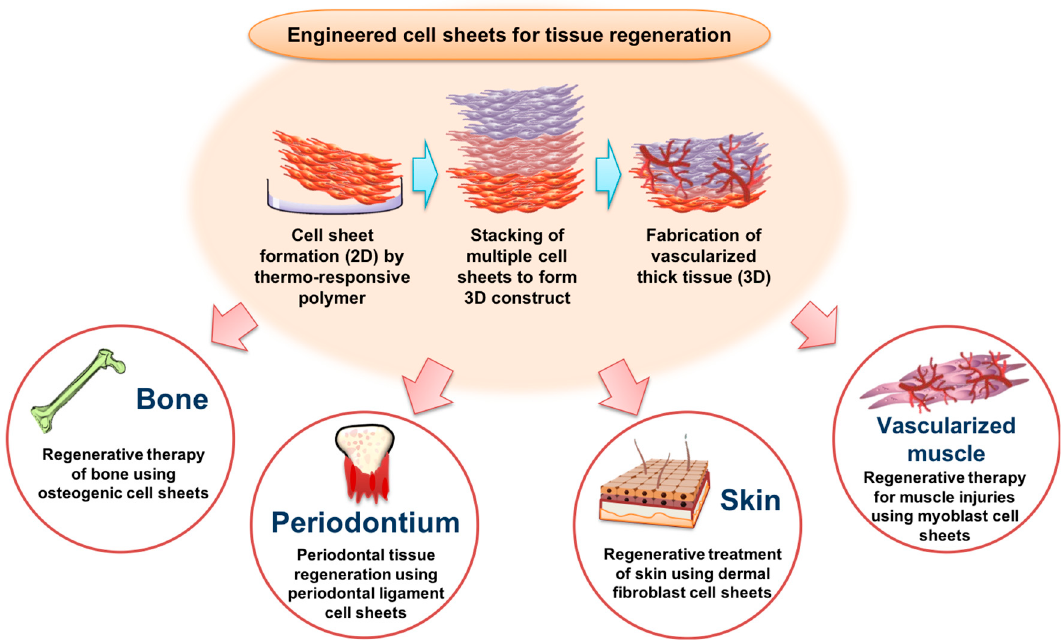
Figure 1. Schematic illustrations of temperature-responsive three dimensional (3D) vascularized cell sheet constructs for tissue regeneration.